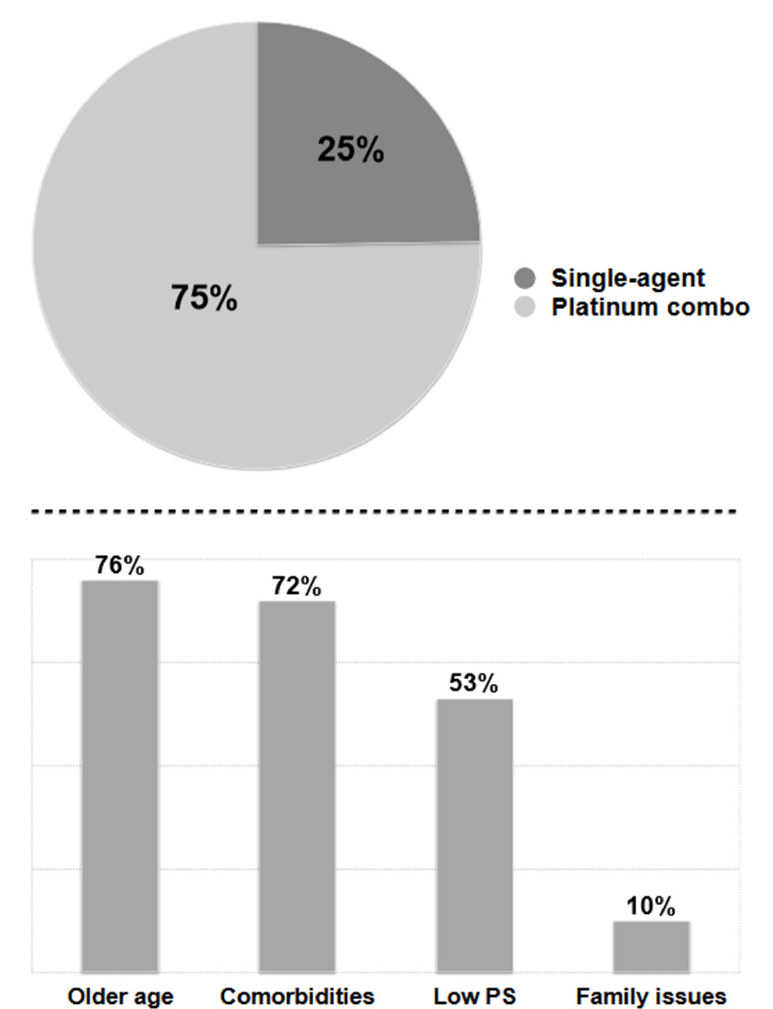
Figure 1. Treatment disposition related to platinum use in first-line EGFR/ALK negative and PD-L1 < 50% advanced NSCLC (upper panel) and main reasons to avoid platinum (lower panel). Single-agent treatment consisted of oral metronomic vinorelbine (n = 174/221 78.6%), gemcitabine (n = 22/221 10%), oral standard vinorelbine (n = 18/221 8.2%), and other (pemetrexed, docetaxel) (n = 7/221 3.2%) (Table 1). Median PFS did not show significant differences among the four groups of single agent treatment, ranging from 4.5 to 5 months. A similar situation was observed in overall survival (OS) with no single agent showing a clear survival advantage. Overall survival ranged from 9 to 10.5 months. Single agent treatments showed an interesting DCR ranging from 60% to 77% with an ORR around 15% without significant differences among